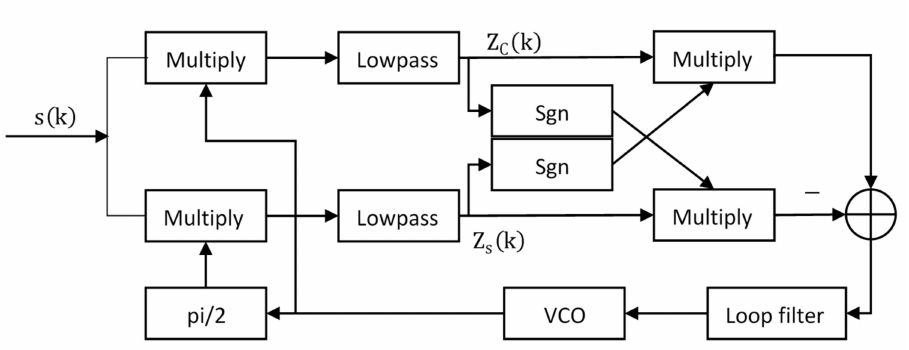
Figure 11. Carrier phase estimation principle diagram. From Figure